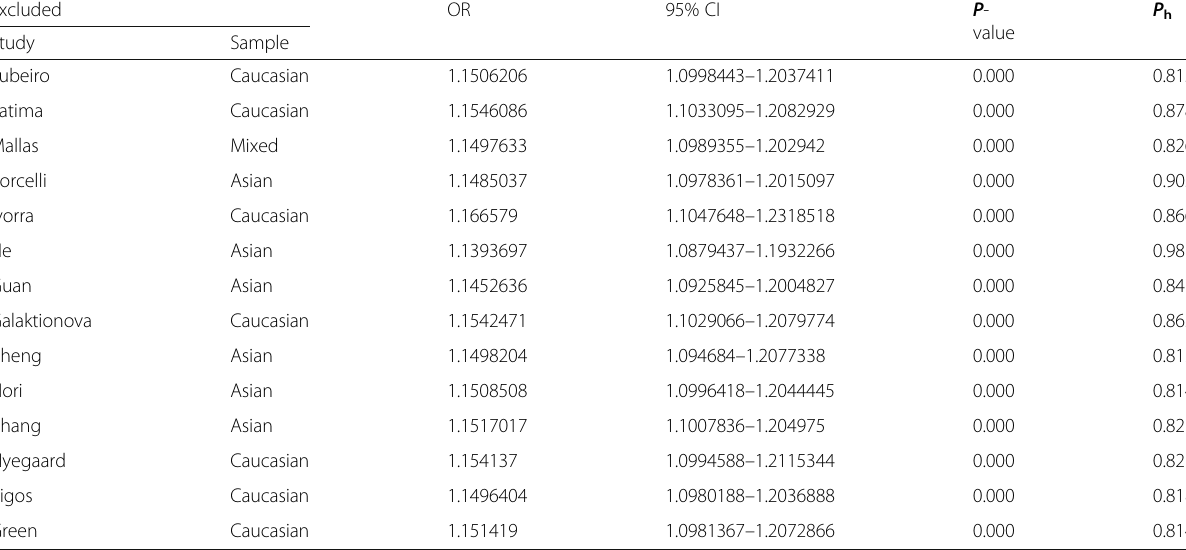
Table 5 Results of the sensitivity analysis for the CACNA1C rs1006737